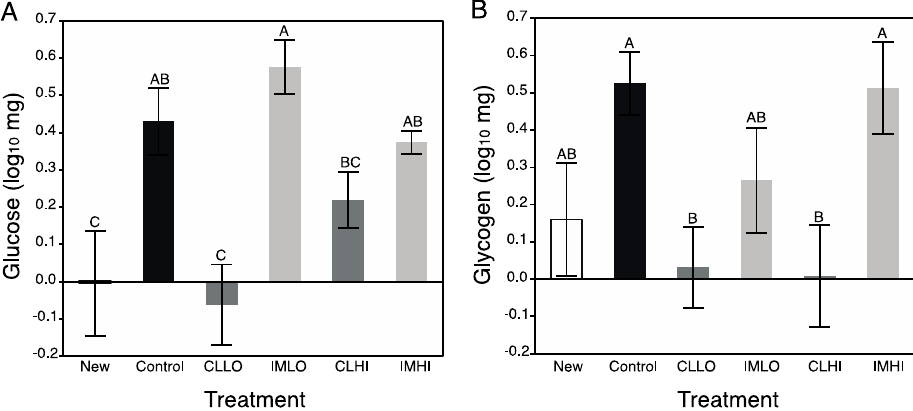
Figure 4. Mean ( ± s.e.m) log 10 -transformed quantity of glucose ( A ) and glycogen ( B ), measured by spectrophotometric assays of homogenized tissues of individual newly emerged honey bees, and those from pesticide treatment groups after two weeks. White bar = Newly emerged bees; Black bar = Control treatment; Dark grey bars = Clothianidin Low (CLLO) and High (CLHI) dose treatments; Light grey bars = Imidacloprid Low (IMLO) and High (IMHI) dose treatments. Letters above bars represent significant differences across treatments from Student’s post hoc tests.